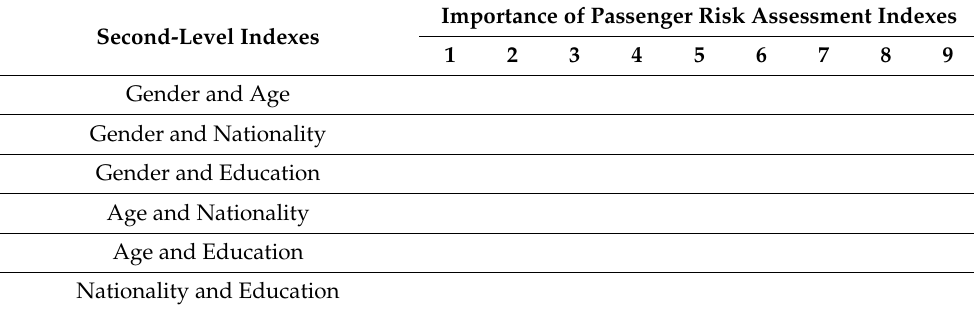
Table A2. Second-level indexes (basic background).